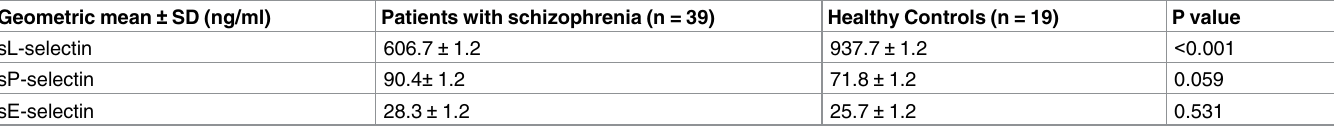
Table 2. Comparison of selectin levels in patients and control